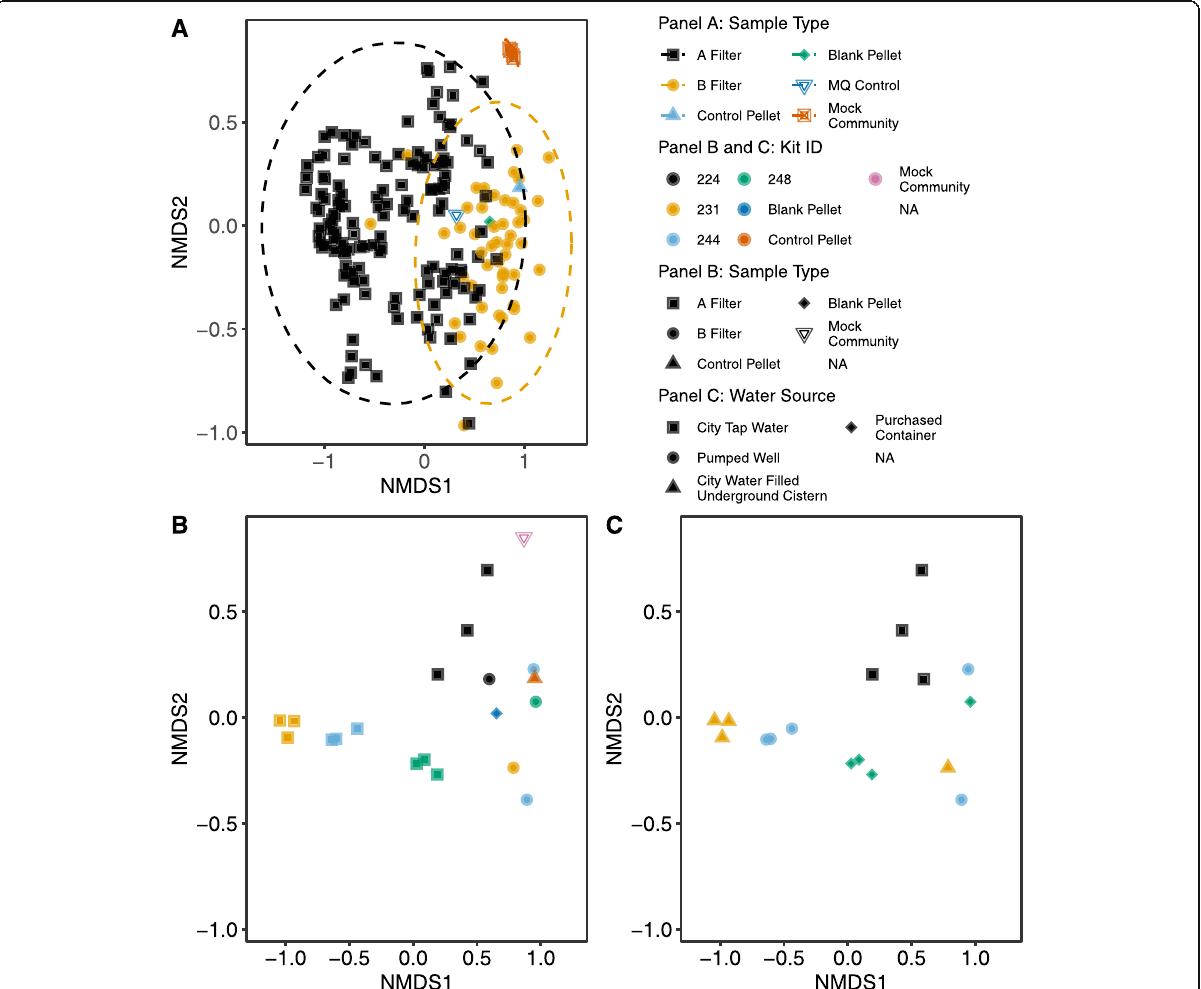
Fig. 5 NMDS ordination ( k = 3, stress = 0.141) of Bray-Curtis pairwise distances of bacterial communities from drinking water sources collected in the study (either home or school locations). Each water source was sampled with a kit consisting of three tandem filters (Filter A and Filter B), yielding three biological replicates of a water source per kit. Each point represents backflushed contents from Filter A, Filter B, laboratory backflush controls, mock community controls, or negative controls. Each kit is represented by up to 3 Filter A points and 3 Filter B points. Samples with fewer than 5000 sequencing reads were not included in the analysis. The same ordination is used for all three panels. a All backflush samples included in the study and associated controls. Shape and color delineate whether a sample is from Filter A, Filter B, or a control. b A subset of four kits selected to show the relationship between biological replicates of Filter A and Filter B within and between kits. Shape delineates Filter A, Filter B, and control samples. Color delineates which kit (i.e. water source) each filter sample represents along with the type of control. c The same kits as shown in b with identical coloring showing kit membership. Shape delineates the type of water